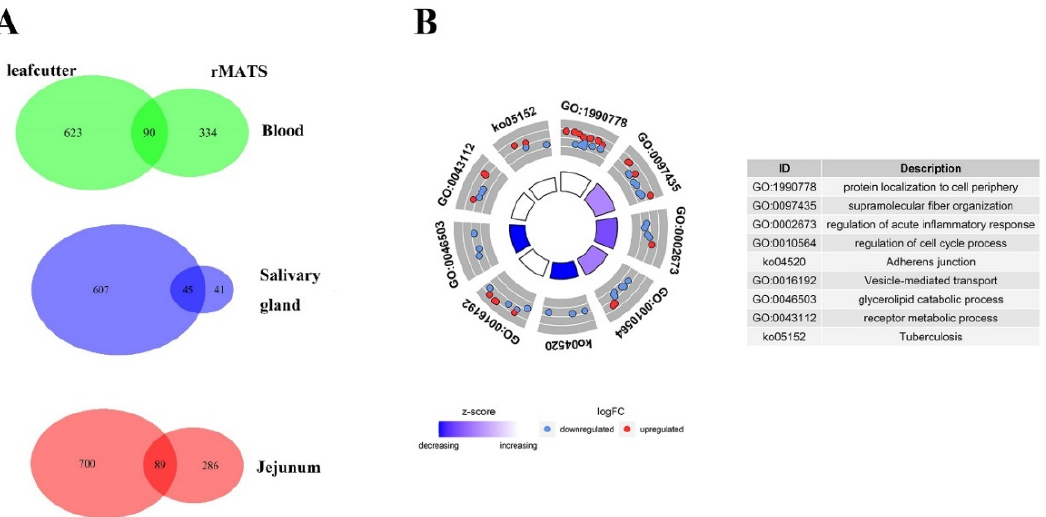
Figure 2. Results of screened DAS events. ( A ) Numbers of screened DAS events. Three Venn diagrams on the left mean numbers of DAS events detected by each software and their overlapped results in different tissues. The one on the right is the intersection of the three tissues. ( B ) Circle figure of pathways enriched results of genes related to screened DAS events. Log2FoldChange values used to calculate Z-score were replaced by ∆ PSI values of DAS events.